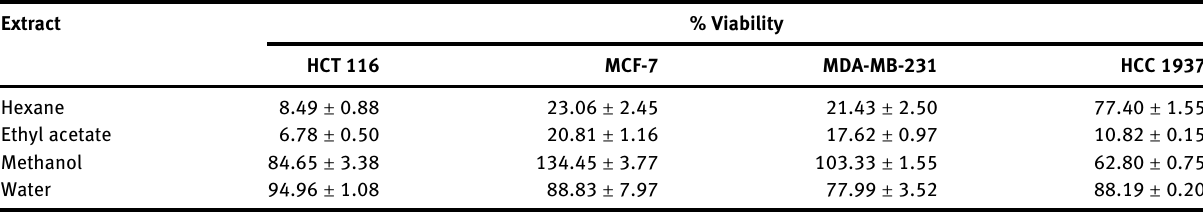
Table  : High dose MTT analyses of C. hystrix crude extracts. Extract